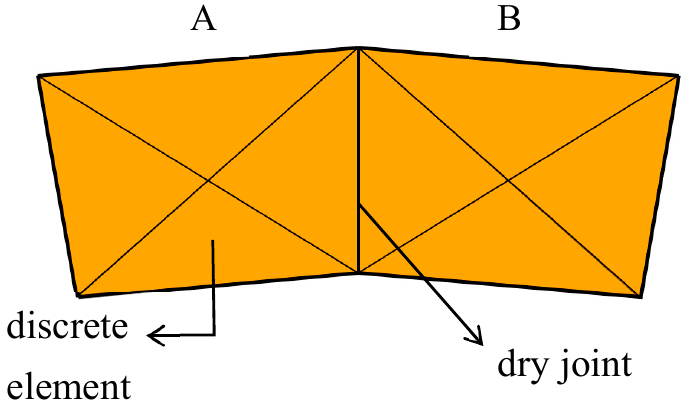
Figure 1. Discretisation of arch voussoirs.